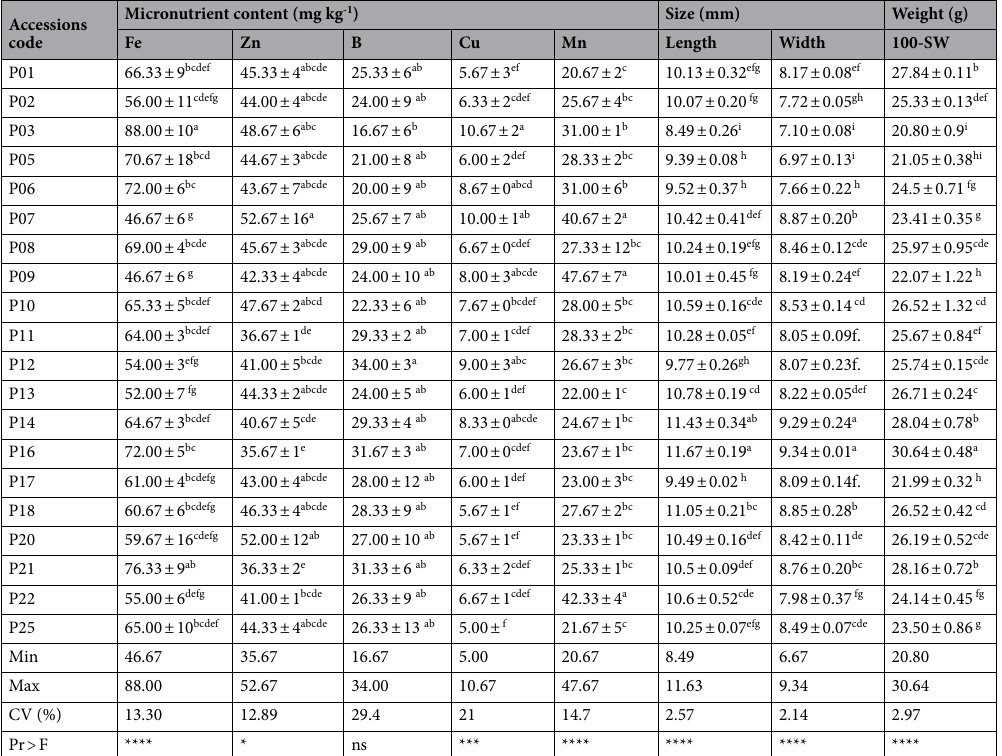
Table 1. Genotype by trait data for 20 early-flowering accessions of L. mutabilis for eight traits. Data are expressed as mean ± SD. Significant differences between treatments ( P < 0.05) are indicated by different letters (ns: no significant differences; * p < 0.05; *** p < 0.001 and **** p <